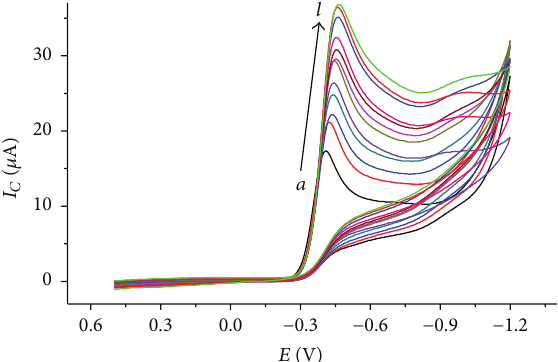
Figure 2: Cyclic voltammograms of 1mM metronidazole in BRB solution (pH 2.0) using CPE at various scan rates ( a – l : 10, 20, 40, 60, 80, 100, 125, 150, 175, 200, 225, and 250 mVs −1 , resp.).